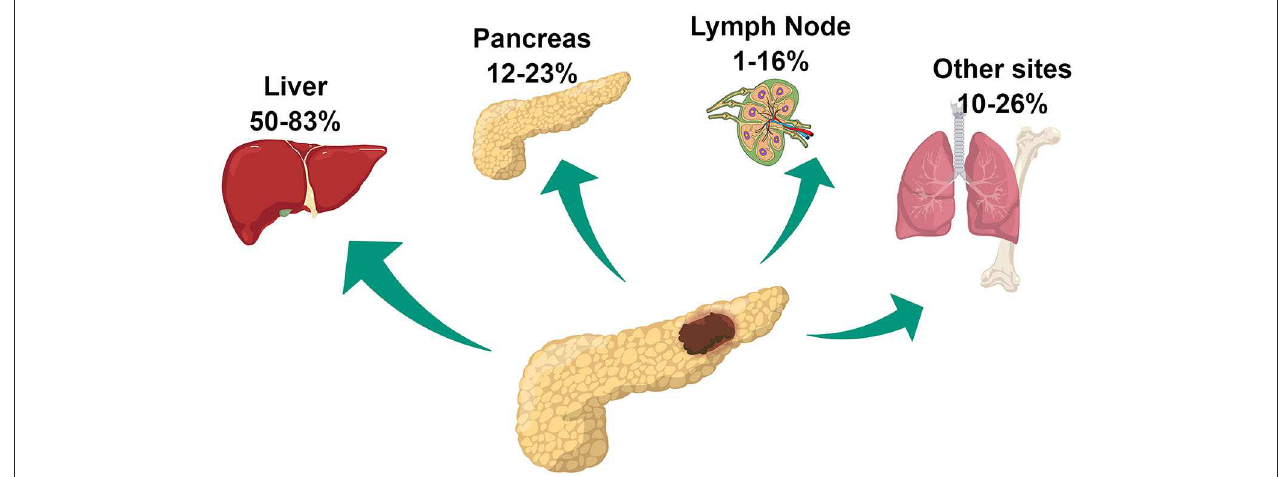
FIGURE 1 | PanNET pattern of recurrence following surgical resection (14,